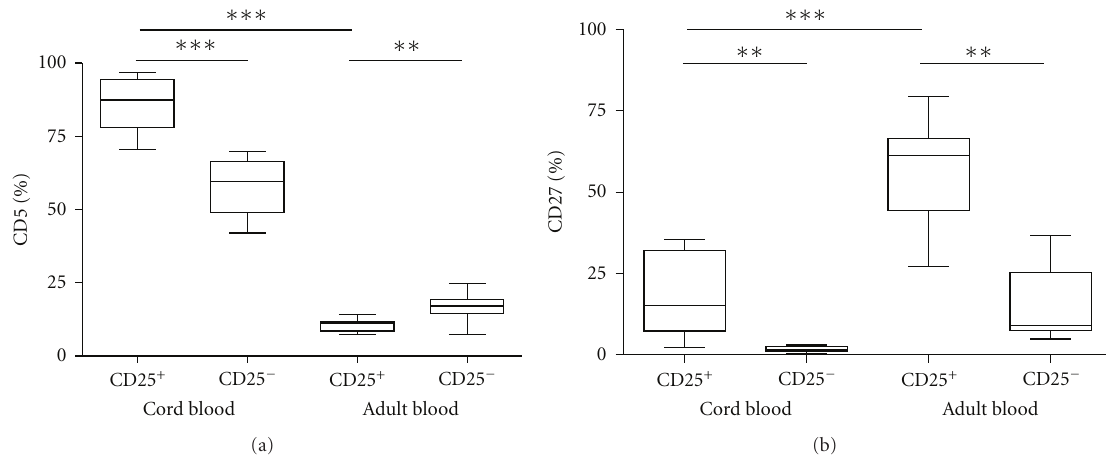
Figure 2: Expression of the CD5 and CD27 epitopes in CD25 + and CD25 − CD20 + B cells isolated from cord blood and adult blood. From freshly isolated cord blood ( N = 10) or adult blood, mononuclear cells ( N = 10) were isolated by density gradient centrifugation. Cells were stained for 3-colour flow cytometry analysis using a combination of CD20, CD25, CD5, or CD27. In (a) the CD5 and in (b) the CD27 expression on CD25 + and CD25 − CD20 + , B cells isolated from cord blood or adult blood are shown. Line in boxes represents median. Statistical evaluation was performed using the parametric unpaired t -test when comparing results from cord blood versus results from adult blood, whereas when comparing results within each group, the paired t -test was used. ∗ P ≤ 0 . 01, ∗∗ P ≤ 0 . 001, ∗∗∗ P ≤ 0 .